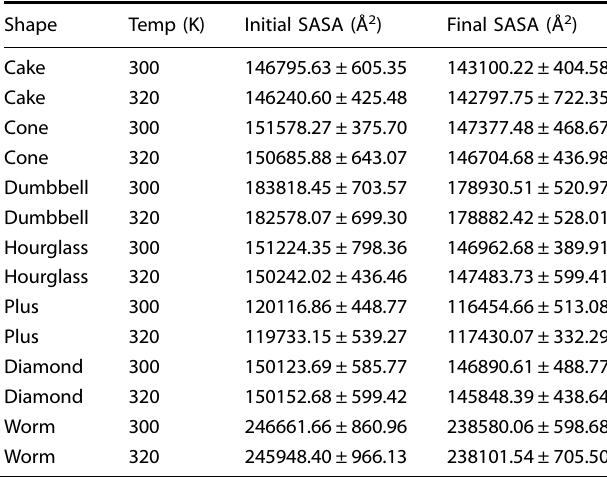
Table 1. Solvent accessible surface area (SASA) values for the overall